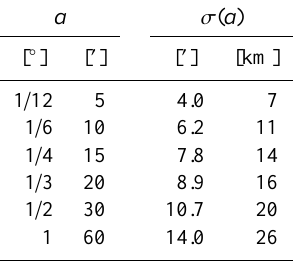
Table 2. Model for the relation between resolution a and